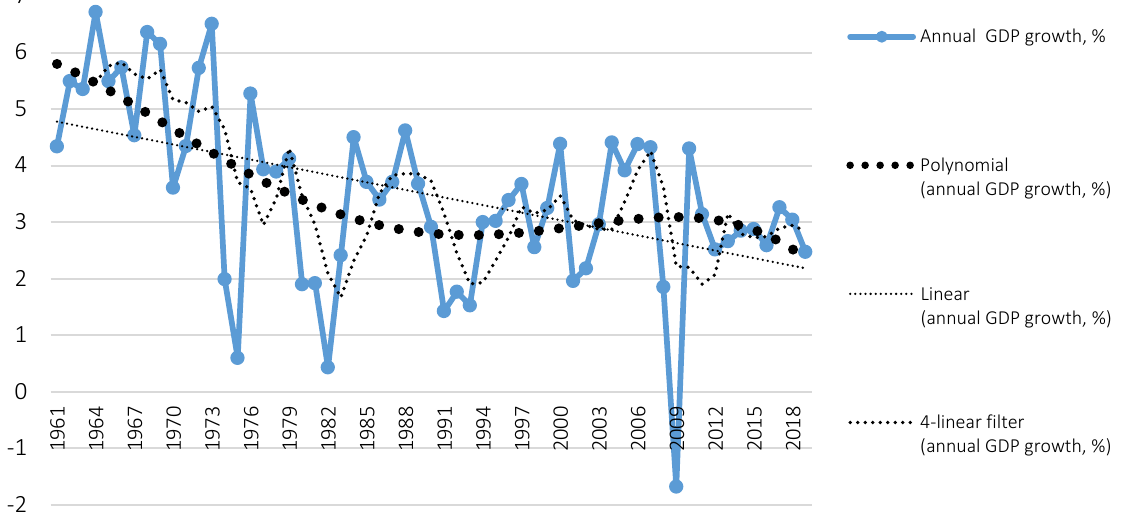
Figure 1. Global GDP cyclical